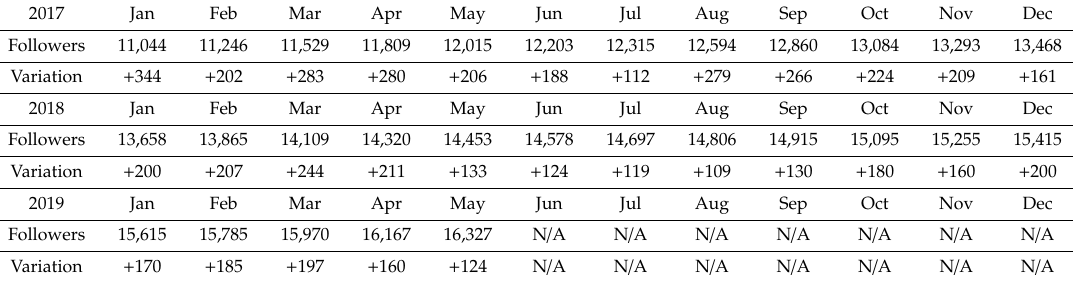
Table 4. CEE followers’ evolution on Twitter